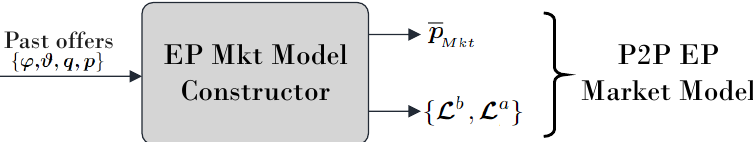
Figure 2. Building the probabilistic model for the discrete time energy packages market, based on the history of offers made and their respective results in the